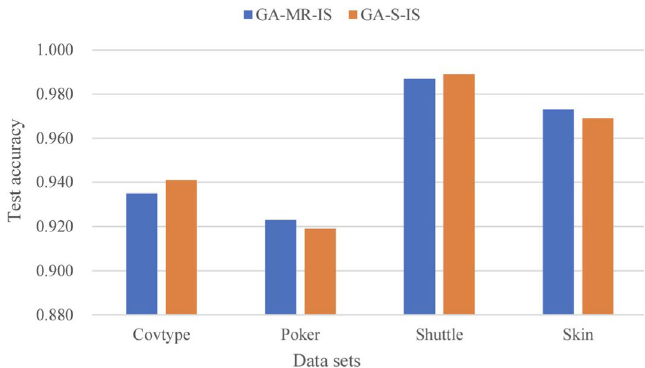
Fig. 7 The comparison of the test accuracy of two